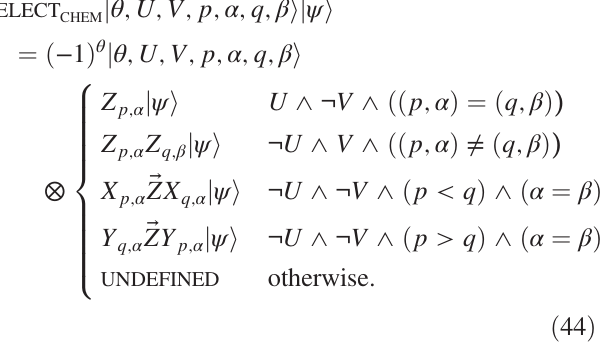
⃗ ZA A apply the operation Z 0 … Z to the target register, j j − 1 j is a variant of Fig. 7, with the X l gate replaced by Z l . q